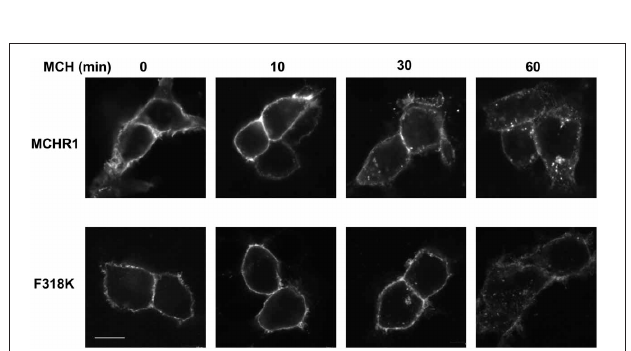
FIGURE 3 | Confocal immunolocalization of Flag-MCHR1 and the mutant receptors using an anti-Flag M2 antibody in HEK293T cells. Cell surface expression was compared using transfected non-permeabilized cells (-TX100, without Triton X-100; upper row) and permeabilized cells (+TX100, with Triton X-100; lower row). Vector-transfected cells incubated with the anti-Flag M2 antibody showed no significant staining (data not shown). Bar, 10 μ m.